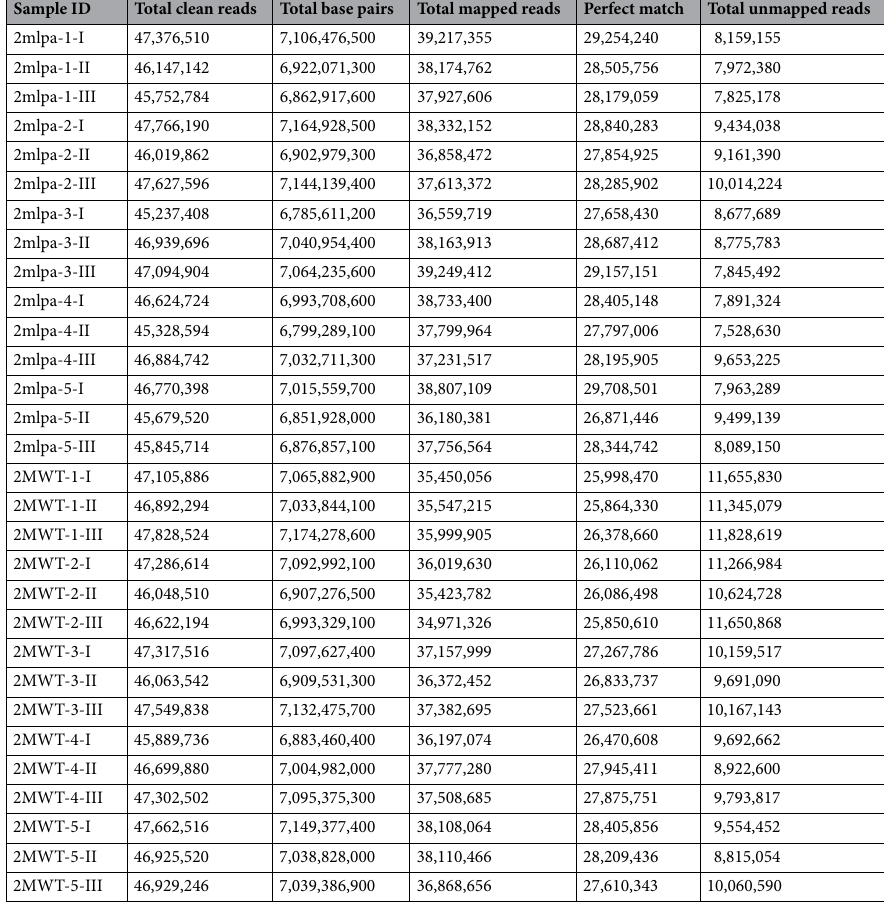
Table 1. Summary of the library read